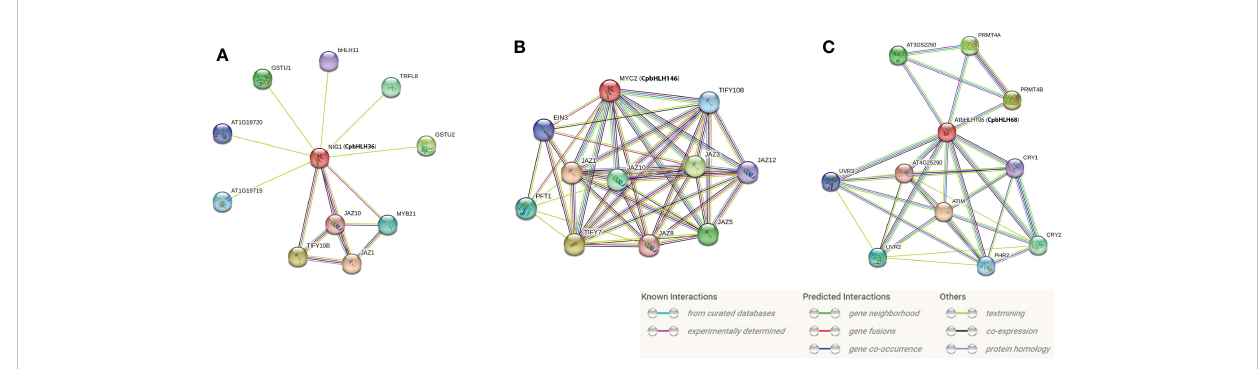
FIGURE 10 Interaction network analysis for CpbHLH36 (A) , CpbHLH146 (B) and CpbHLH68 (C) . The predicted results are based on the orthologous gene in Arabidopsis. CpbHLH genes are shown in brackets.